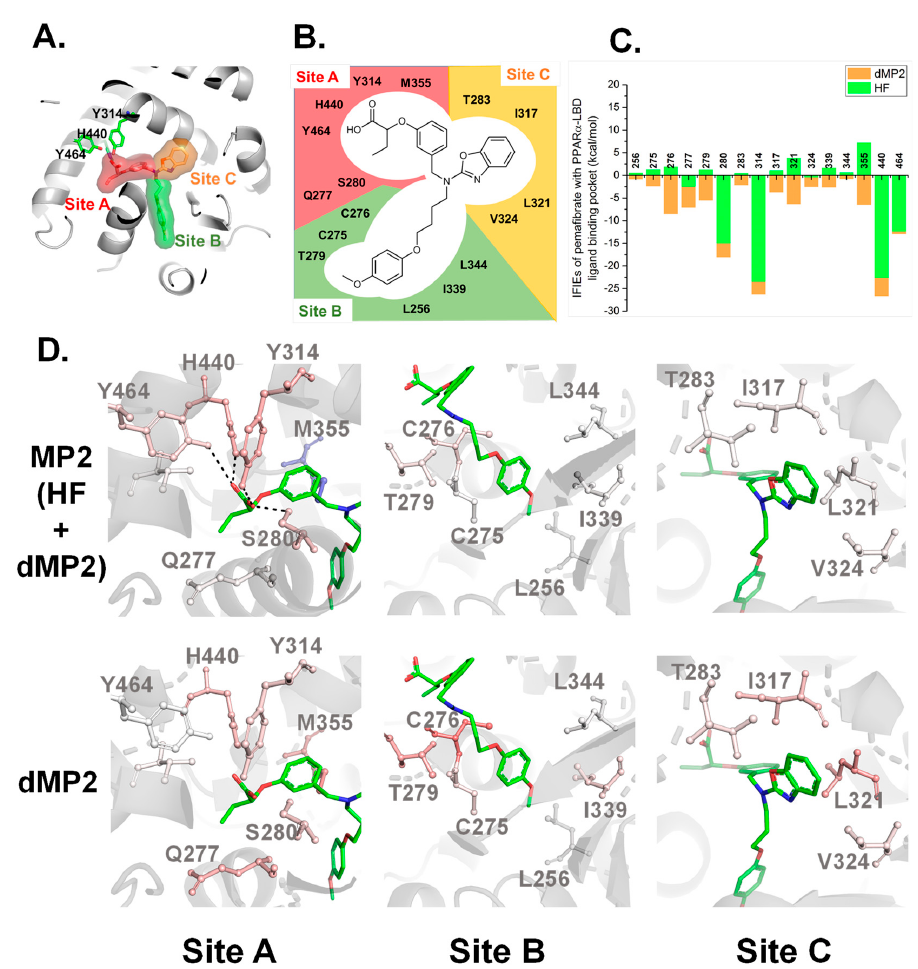
Figure 3. ( A ) Division of the LBP site of PPAR α into three sites. The LBP is divided into three sites: site A (red surface), site B (green surface), and site C (orange surface). ( B ) Potential interacting residues at the LBP of PPAR α with pemafibrate. A total of 16 residues were located within 3.2 Å distance from pemafibrate. ( C ) Significant interfragment interaction energies (IFIEs) between pemafibrate and LBP residues of PPAR α . The HF-IFIEs and dMP2-IFIEs represented in green and orange, respectively. ( D ) Representation of MP2-IFIEs (upper row) and dMP2-IFIEs (bottom row) at the three sites on the crystal structure of the PPAR α -LBD / pemafibrate / SRC1 peptide. The structures are colored depending on the magnitude of the IFIEs value. Positive (repulsive) and negative (attractive) IFIEs are colored by blue and red, respectively.